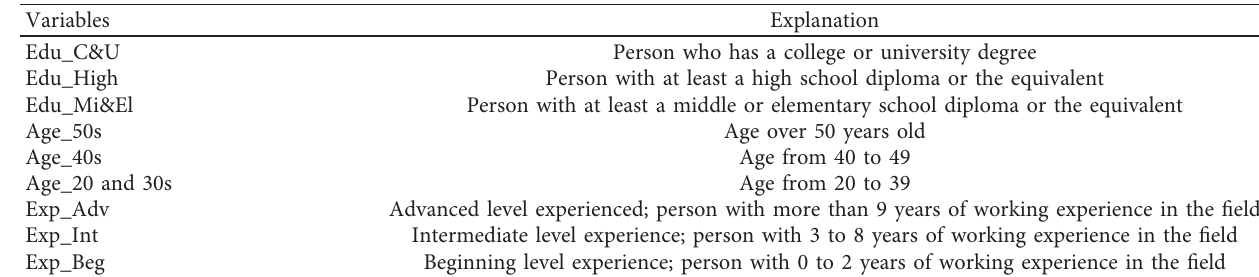
Figure 5: Outline t -test of trainees’ understanding by workers’ personal factors. Table 3: Classification of variables for workers’ personal